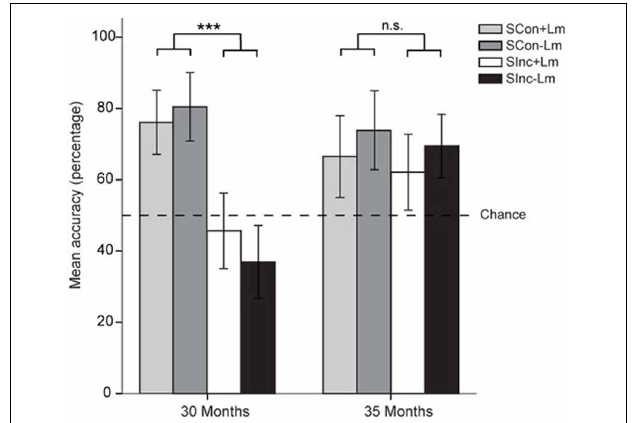
FIGURE 3 | Spatial orientation task performance. Mean accuracy scores and 95% confidence intervals by age group for Side-congruent with landmark (SCon + Lm; light gray), Side-congruent without landmark (SCon − Lm; dark gray), Side-incongruent with landmark (SInc + Lm; white), and Side-incongruent without landmark (SInc − Lm; black) conditions. ∗∗∗ p < 0 . 001.